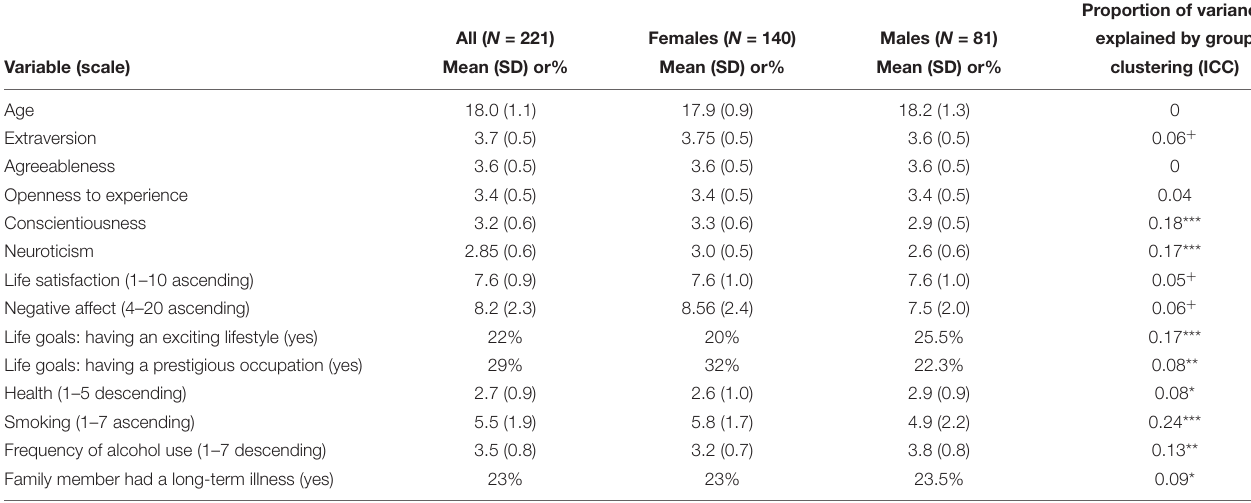
TABLE 1 | Descriptive statistics and factors associated with group formation ( N = 221; Wave